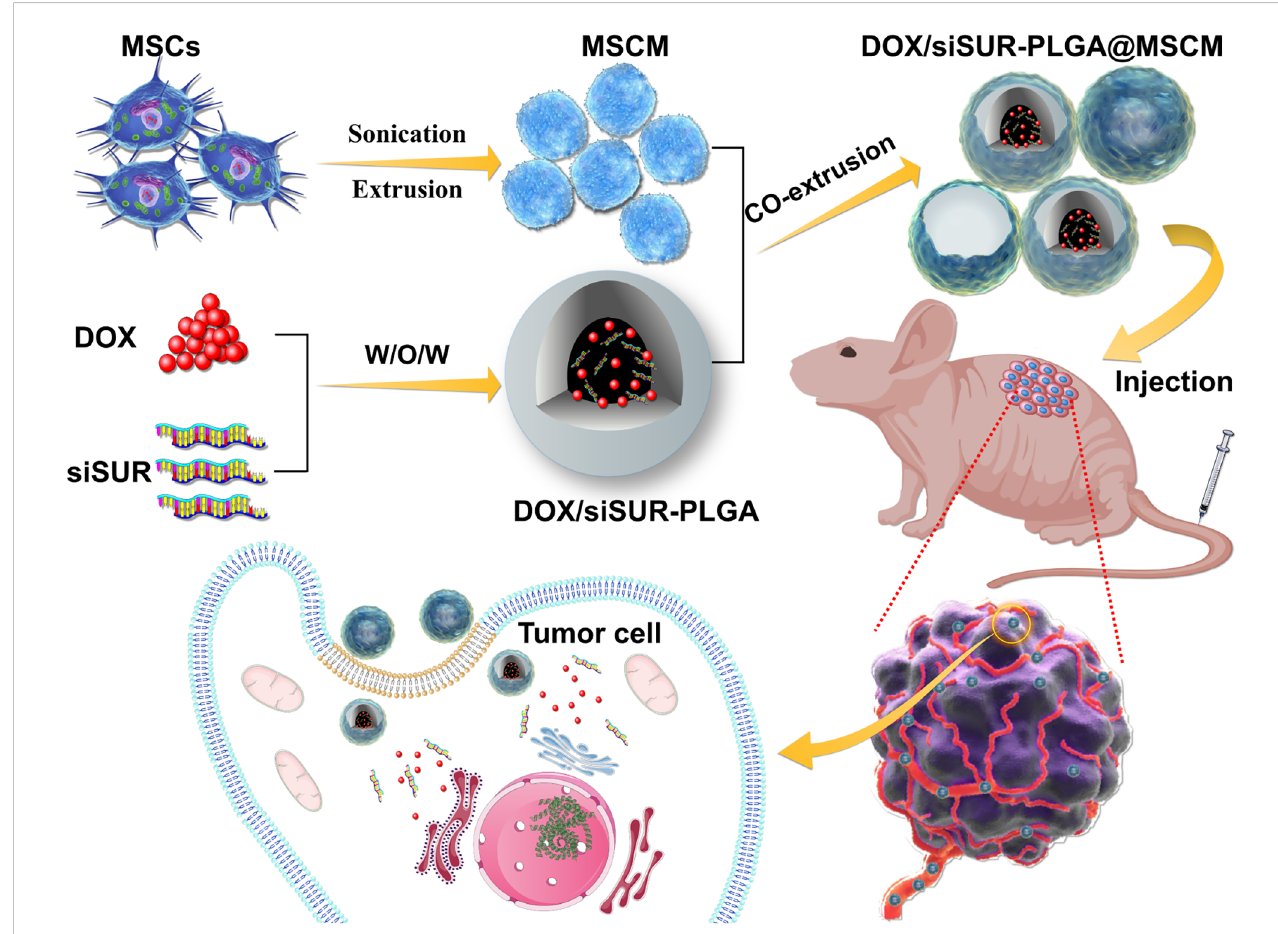
FIGURE 1 Mesenchymal stem cell membrane-camou fl aged nanoparticles coloaded with DOX and survivin siRNA for osteosarcoma